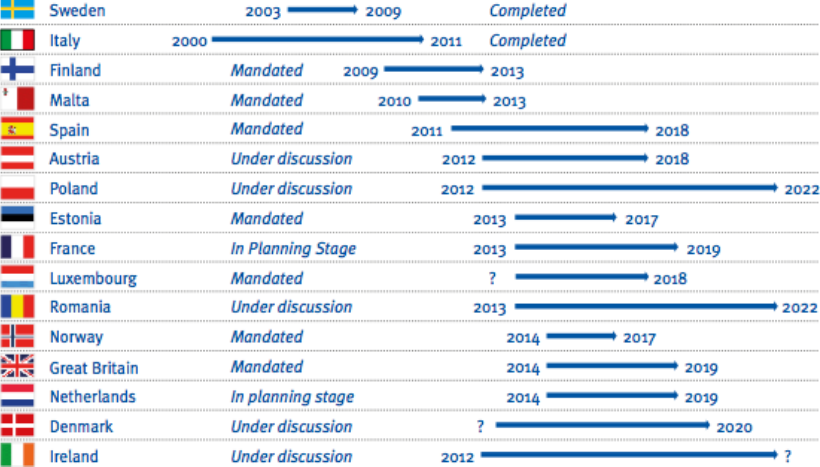
Figure 4. SM rollout status in Europe by country (Source: European Commission [52]). Reprinted with